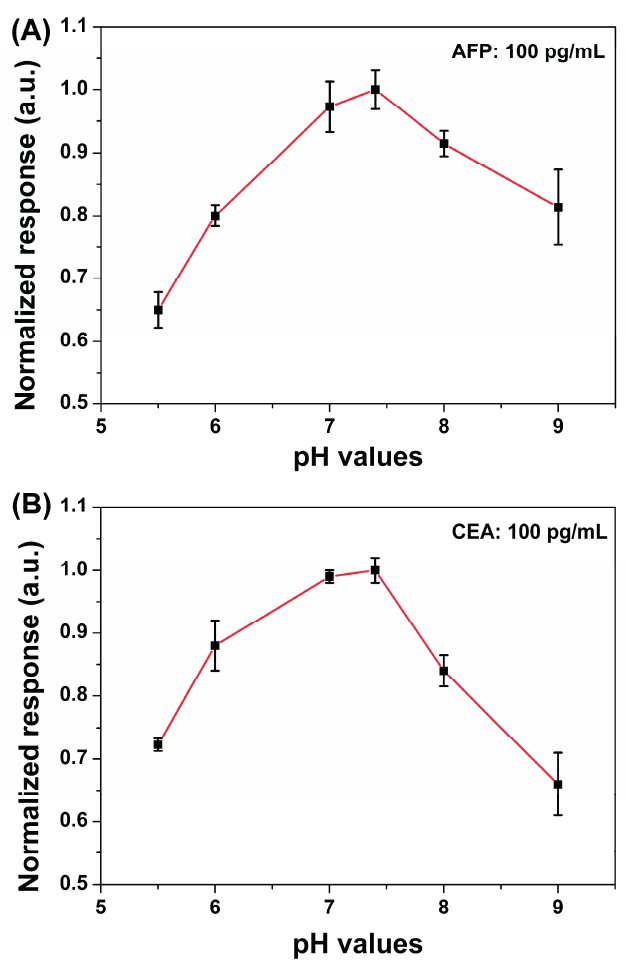
Figure 5. Response behavior to 100 pg/mL AFP ( A ) and CEA ( B ) versus different pH values of measured